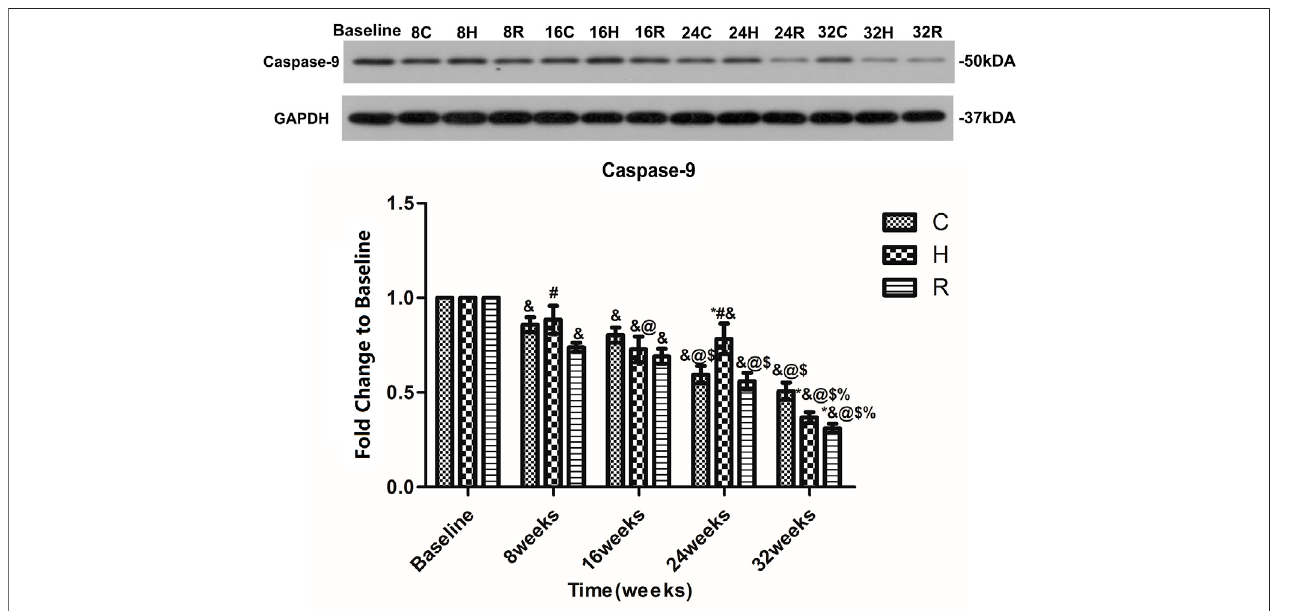
FIGURE 8 | Age and exercise training effects on Caspase-9 levels in mitochondria of soleus muscle, were evaluated by Western blot. * Signi fi cant different from C and other group; # Signi fi cant different from H and R; & Signi fi cant different from Baseline and other weeks; @ Signi fi cant different from 8 weeks and other weeks; $ Signi fi cant different from 16 weeks and other weeks; % Signi fi cant different from 24 weeks and other weeks. ( p < 0.05).